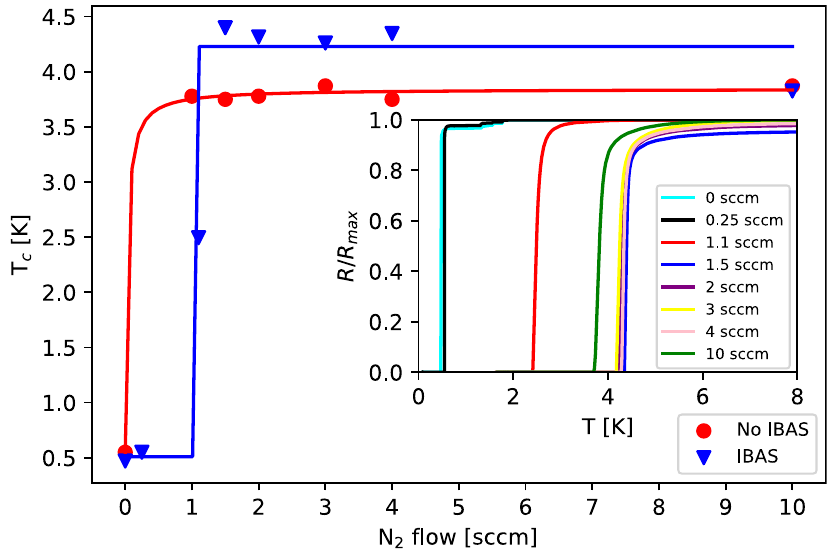
Figure 1. Comparison of bulk 300 nm TiN films dependence of T c on nitrogen flow rates under reactive magnetron sputtering with no ion beam assist (red) and including the ion beam (blue). Trend curves are sigmoid fits meant to serve as guides to the eye. Inset: Normalized resistance transition curves for IBAS grown films at various nitrogen flow points.